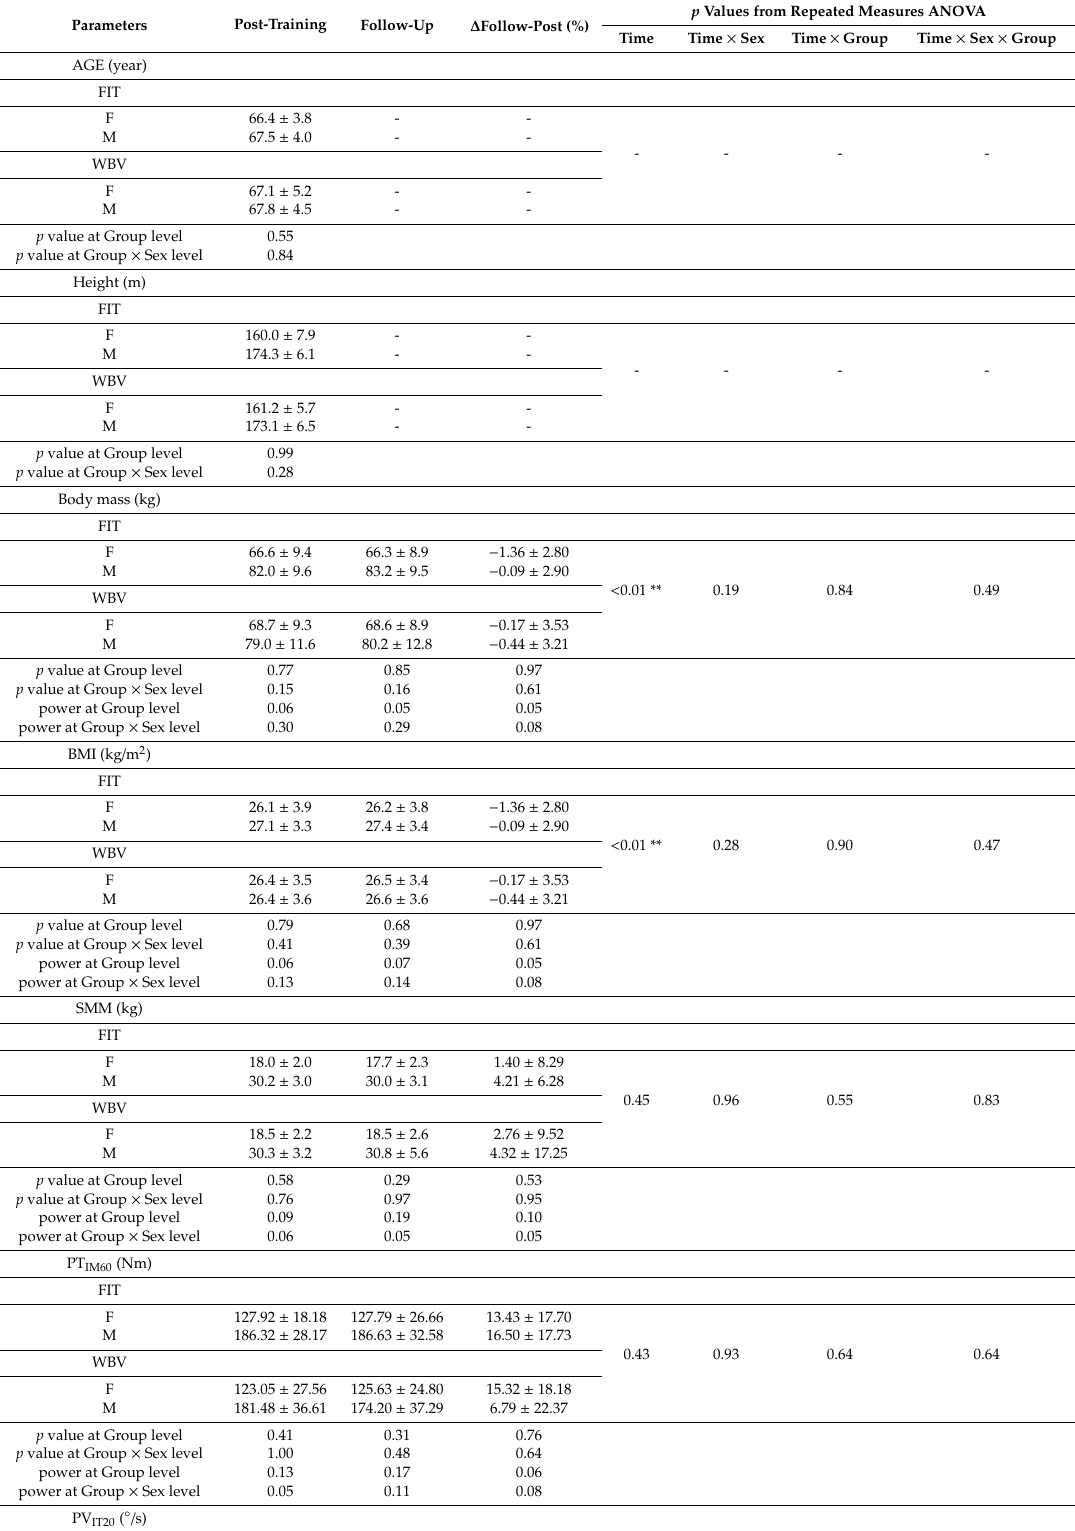
Table 1. Descriptive data and p values from ANOVA of between group comparisons at post-training and follow-up